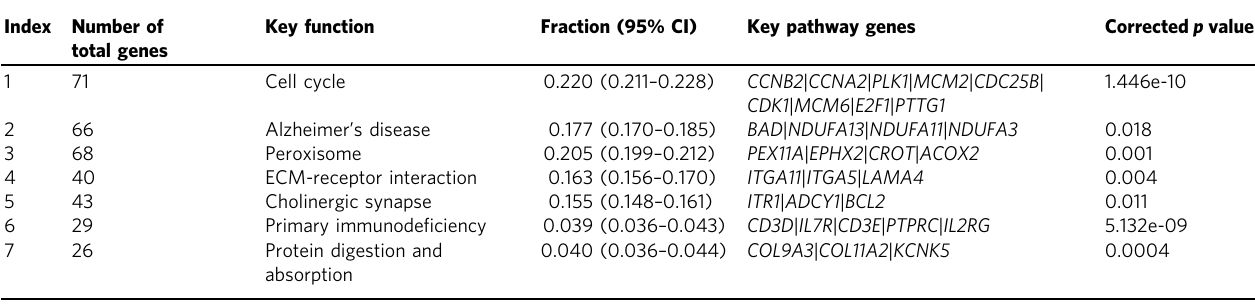
Statistical signi fi cance was assessed by the two-sided hypergeometric test. p values were adjusted for multiple comparisons. HR hazard ratio, CI con fi dence